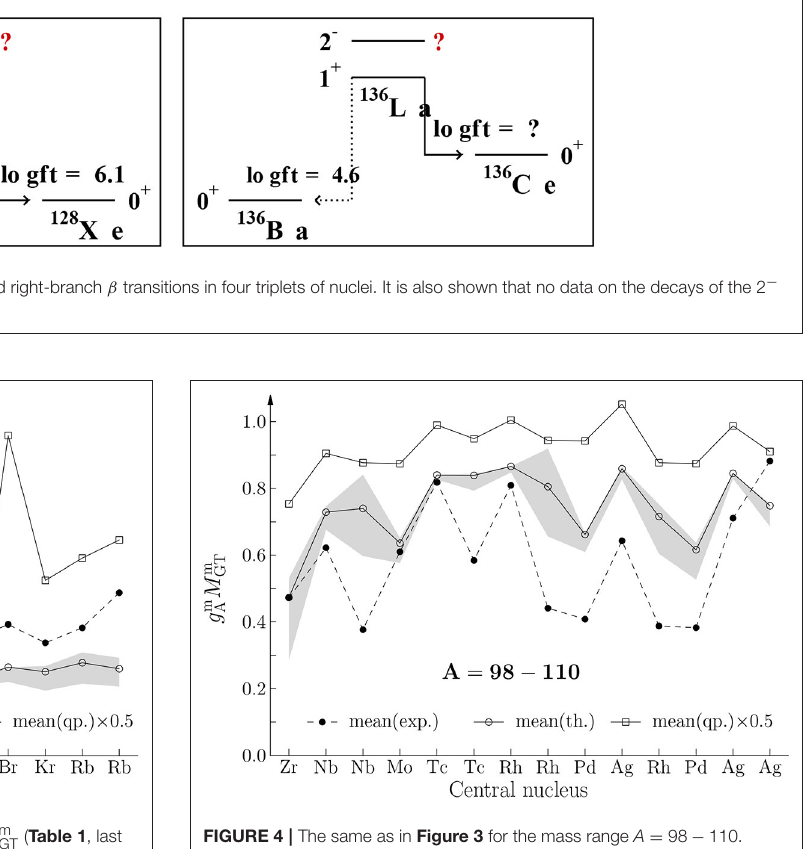
FIGURE 3 | Mean experimental and theoretical NMEs g m A M m GT ( Table 1 , last two columns) for the mass range A the uncertainty of the calculations (the range g pp Also the NMEs in the two-quasiparticle approximation have been plotted for comparison (note the scaling of these NMEs by a factor one-half in order to save vertical space in the figure).